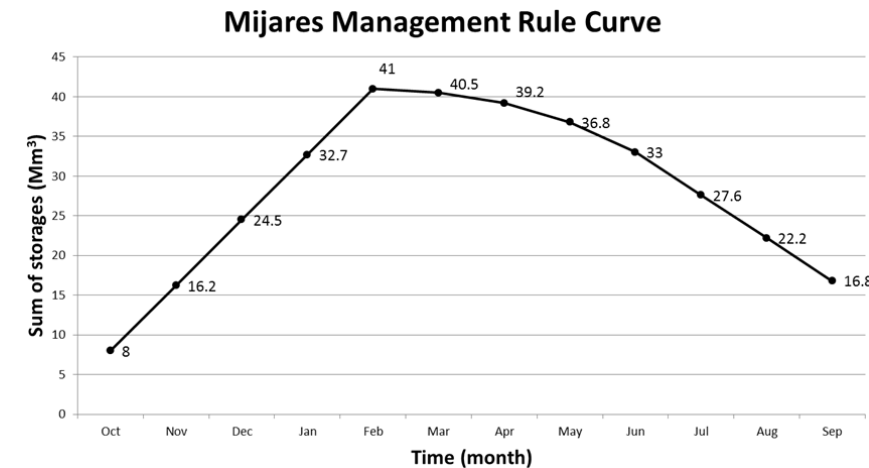
Figure 4. Current management rule curve established in the Mijares River basin.